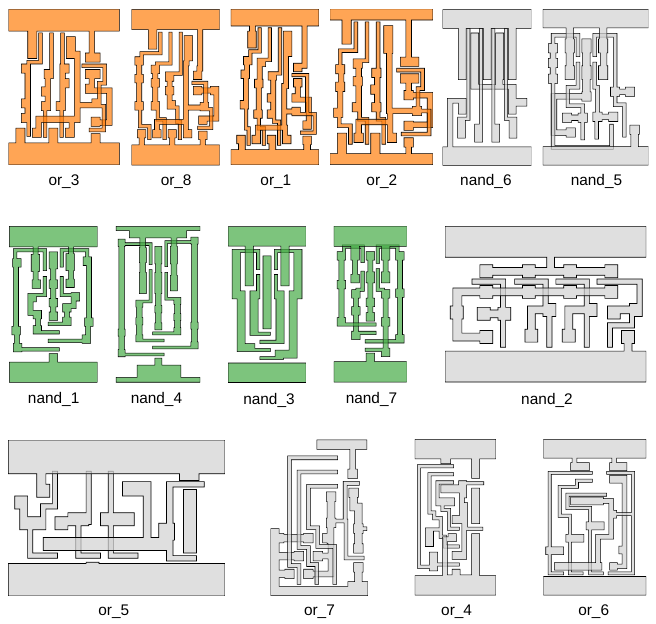
Figure A1. Nets extracted from the pool of NAND and OR gates whose mutual similarity was shown in the dendrogram in Figure